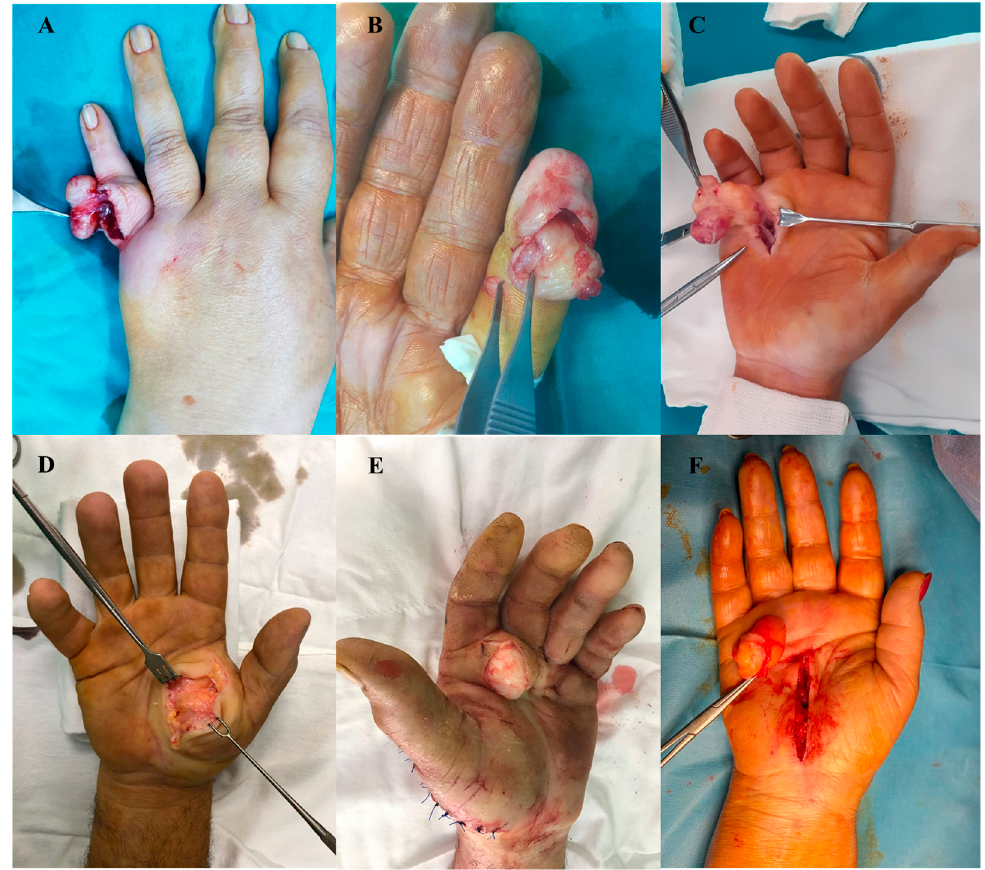
Figure 8. Uncommon sites of hand lipomas. ( A ) first phalanx of the little finger dorsal aspect. ( B ) pulp of the little finger. ( C ) ulnar palmar region. ( D ) thenar eminence. ( E ) radial palmar region, ( F ) medioplamar region .